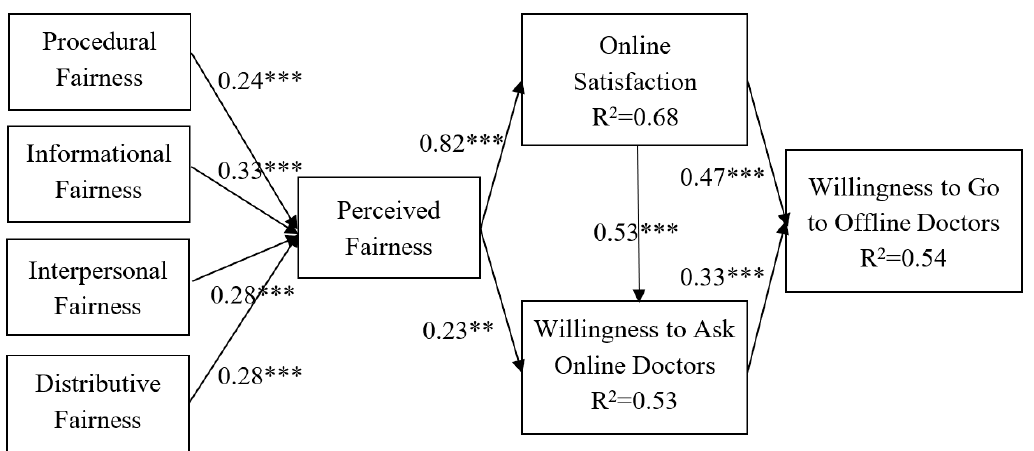
Figure 3. Results. ** p < 0.01; *** p < 0.001.